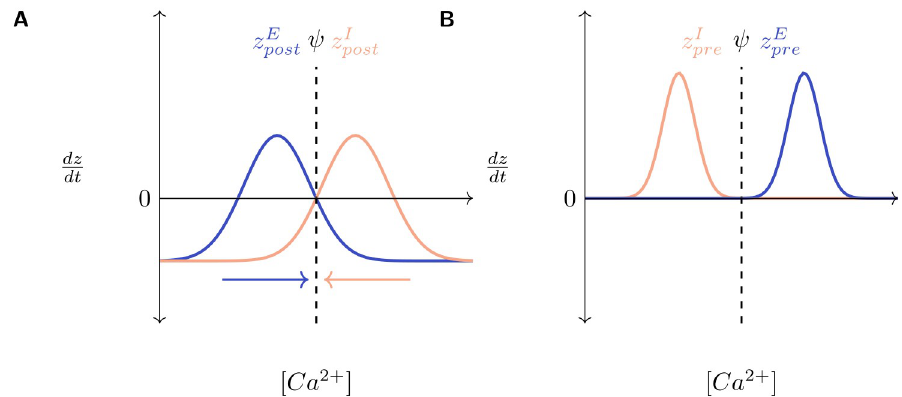
Fig 5. Activity-dependent dynamics of synaptic elements ( dz / dt ) as functions of a neuron’s time averaged activity ([ Ca 2+ ]). (A) post-synaptic elements : Post-synaptic elements of a neuron react to deviations in activity from the optimal level ( ψ ) by countering changes in its excitatory or inhibitory inputs to restore its E-I balance. For both excitatory and inhibitory neurons, excitatory post-synaptic elements sprout when the neuron experiences a reduction in its activity, and retract when the neuron has received extra activity. Thus, the stable fixed point of the growth curve for post-synaptic excitatory neurites is found at � E where the slope of the growth curve is negative. Inhibitory post- post synaptic elements for all neurons follow the opposite rule: they sprout when the neuron has extra activity and retract when the neuron is deprived of activity. The stable fixed point of the growth curve for post-synaptic inhibitory neurites is therefore, found at Z I where the slope of the growth curve is positive. Together, these growth curves ensure that post when the neuron has more than optimal activity, it will lose excitation and attempt to gain inhibition to reduce its net activity (red arrow). Similarly, the neuron attempts to gain excitation and loses inhibition to gain net activity when it has less than optimal activity (blue arrow). The optimal activity level, ψ , thus acts as the stable fixed point for both post- synaptic growth curves. (B) pre-synaptic elements : The connectivity of the network also depends on the pre-synaptic connectivity. Specifically, neurons attempting to gain synapses can only do so if free neurites of the required type are available. In excitatory neurons, axonal sprouting is stimulated by extra activity. In inhibitory neurons, on the other hand, deprivation in activity stimulates axonal sprouting. Synaptic elements that do not find corresponding partners to form synapses (free synaptic elements) decay exponentially with time. These graphs are illustrations of the regimes that the growth curves must